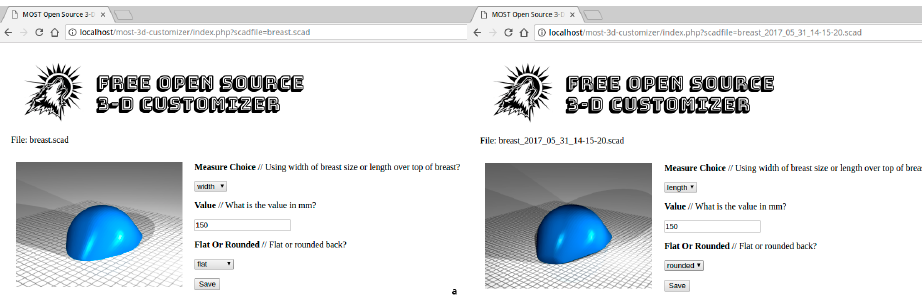
Figure 7. Changing infill (red) of the prosthetic breast model in Slic3r Prusa Edition. The wall or skin (yellow) has no z step line.